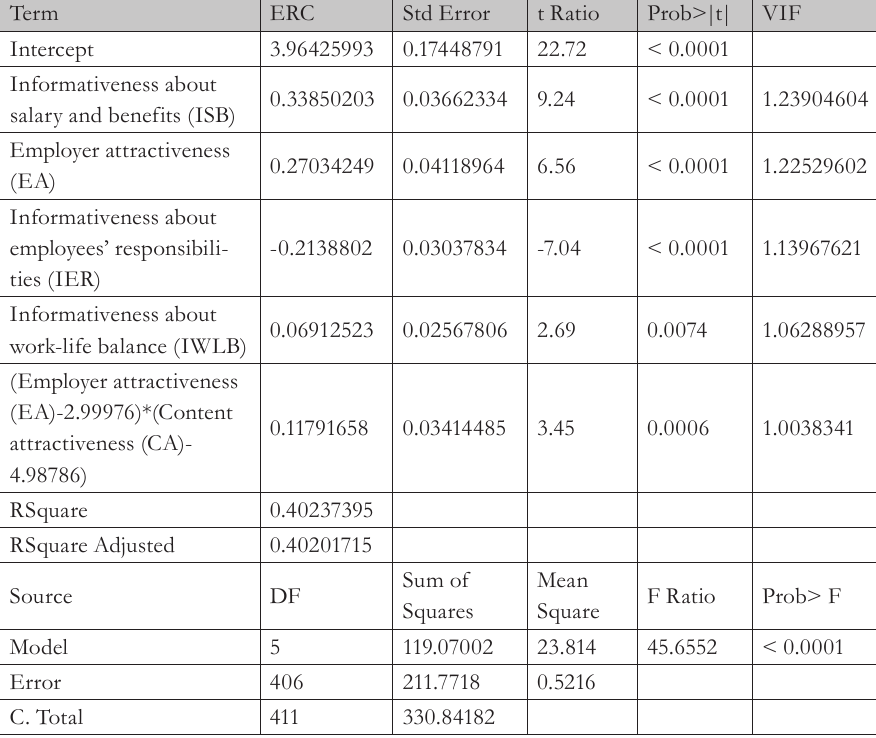
Tab. 4 – The second model. Source: own